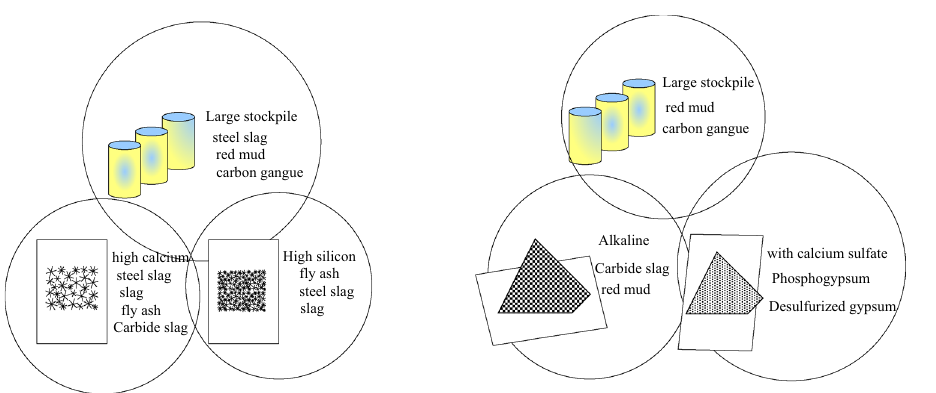
Figure 2. Screening criteria for sustainable curing agent raw materials and excitation